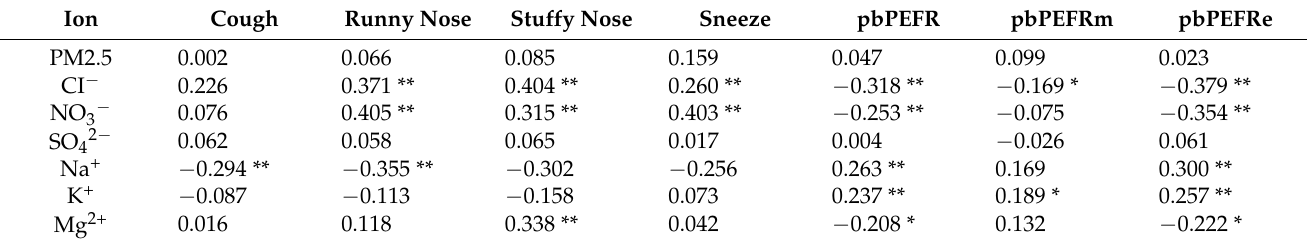
Table 2. Correlation coefficients for the relationship of PM2.5 and ionic concentrations of PM2.5 with daily prevalence of respiratory symptoms and mean personal best peak expiratory flow